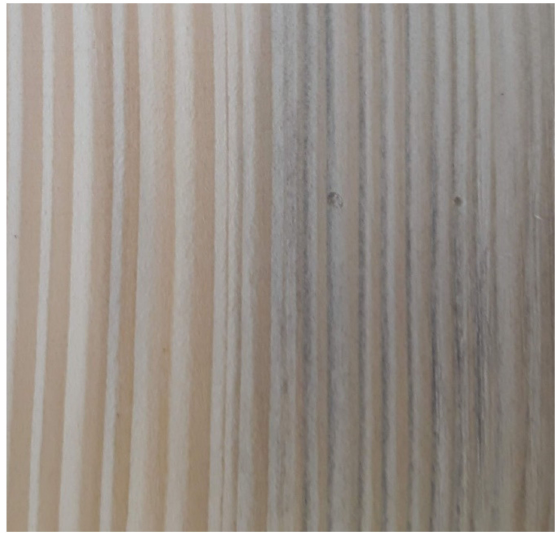
Figure 3. Image of a longitudinal section of bark beetle-attacked Norway spruce wood (on the right), with visible coloration caused by staining fungi (own photo).